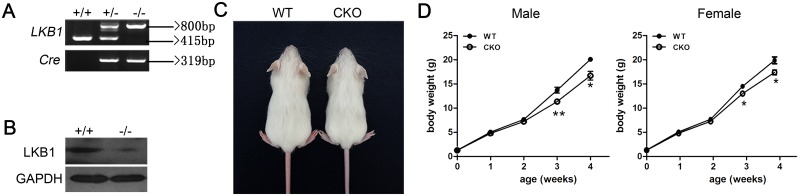
Generation of Atoh1-LKB1-/- conditional knockout mice.(A) Mouse genotyping by PCR analysis. Lanes: wild-type (+/+), heterozygous (+/-) and homozygous (-/-) mice. The LKB1 gene product of the wild-type allele was 415-bp. A 415-bp band and an 800-bp band were detected in the heterozygous mice. Only the 800-bp band was observed in the homozygous mice. The PCR product of the Atoh1-Cre recombinase gene was 319-bp. (B) Western blot analysis of Lkb1 in the cochlea of Atoh1-LKB1-/- and wild-type mice at P14. A 48.6-kD LKB1 protein was decreased obviously in the cochlea of Atoh1-LKB1-/- mice compared with the controls. (C) Gross morphology of wild-type and Atoh1-LKB1-/- mice at P21. There was no obvious difference, except for the smaller size of the mutant mice compared with the controls. (D) The body weight of male and female mice from WT and mutant mice was measured. The mutant mice exhibited significant decreases in weight compared to those of the control group after P21. Error bars indicate SEM. *p<0.05; **p<0.01; ***p<0.001 by Student’s t-test. n = 5 mice per experiment and genotype.